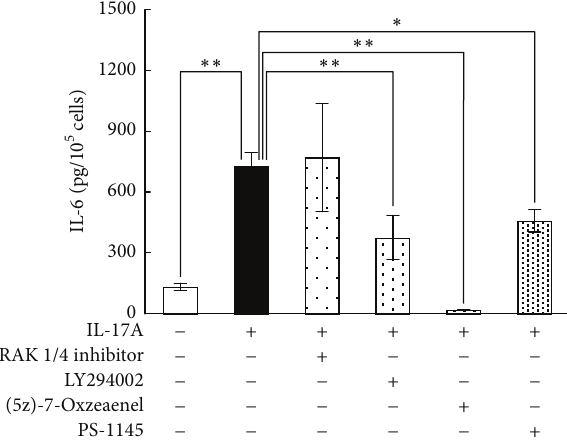
Figure 8: Effect of inhibitors of the NF 𝜅 B signaling pathway on IL-17A-induced IL-6 production by synovial fibroblasts. Synovial fibroblasts were pretreated with the IRAK 1/4 inhibitor (20 𝜇 M), 20 𝜇 M LY294002, 1 𝜇 M (5z)-7-Oxozeaenol, or 10 𝜇 M PS-1145 for 30 minandwerethentreatedwith10 ng/mLIL-17Afor8h,following which the IL-6 protein levels in the conditioned medium were assayed using ELISA. Results are expressed as means ± SD ( 𝑛 = 4 ); ∗ 𝑃 < 0.05 ; ∗∗ 𝑃 < 0.01